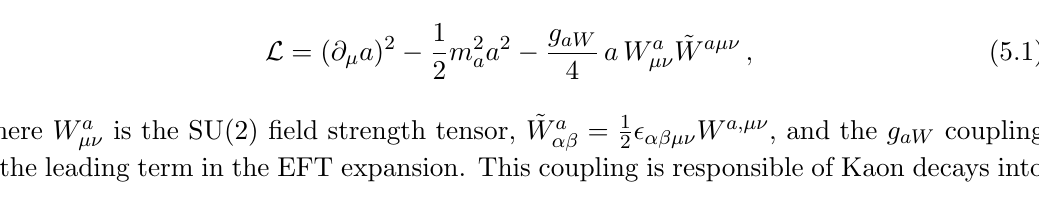
Figure 7 . The future reach of the KOTO experiment to BR( K L ! (cid:25)a ! 4 (cid:13) ). The blue line shows the 2 (cid:27) sensitivity, keeping into account only the statistical uncertainty. The dashed purple line corresponds to the sensitivity with the systematic uncertainty of 1%, i.e., S > 2( and the dashed green line is for 10% systematics. Also, the red line corresponds to the sensitivity of the analysis without CUT10 which is e(cid:11)ective for ALP masses close to the pion mass, m a = 130 ; 140